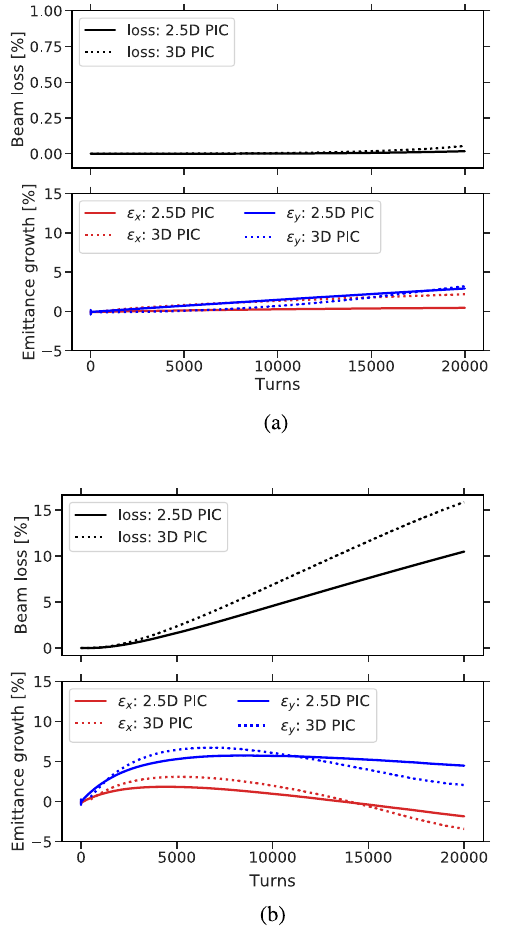
FIG. 23. Simulations with 2.5D and 3D self-consistent PIC models for the full field error model. (a) Optimal working point Q ¼ 18 . 97 , Q ¼ 18 . 85 . (b) Resonance-affected working point x y Q ¼ 18 . 84 , Q ¼ 18 . 73 x y